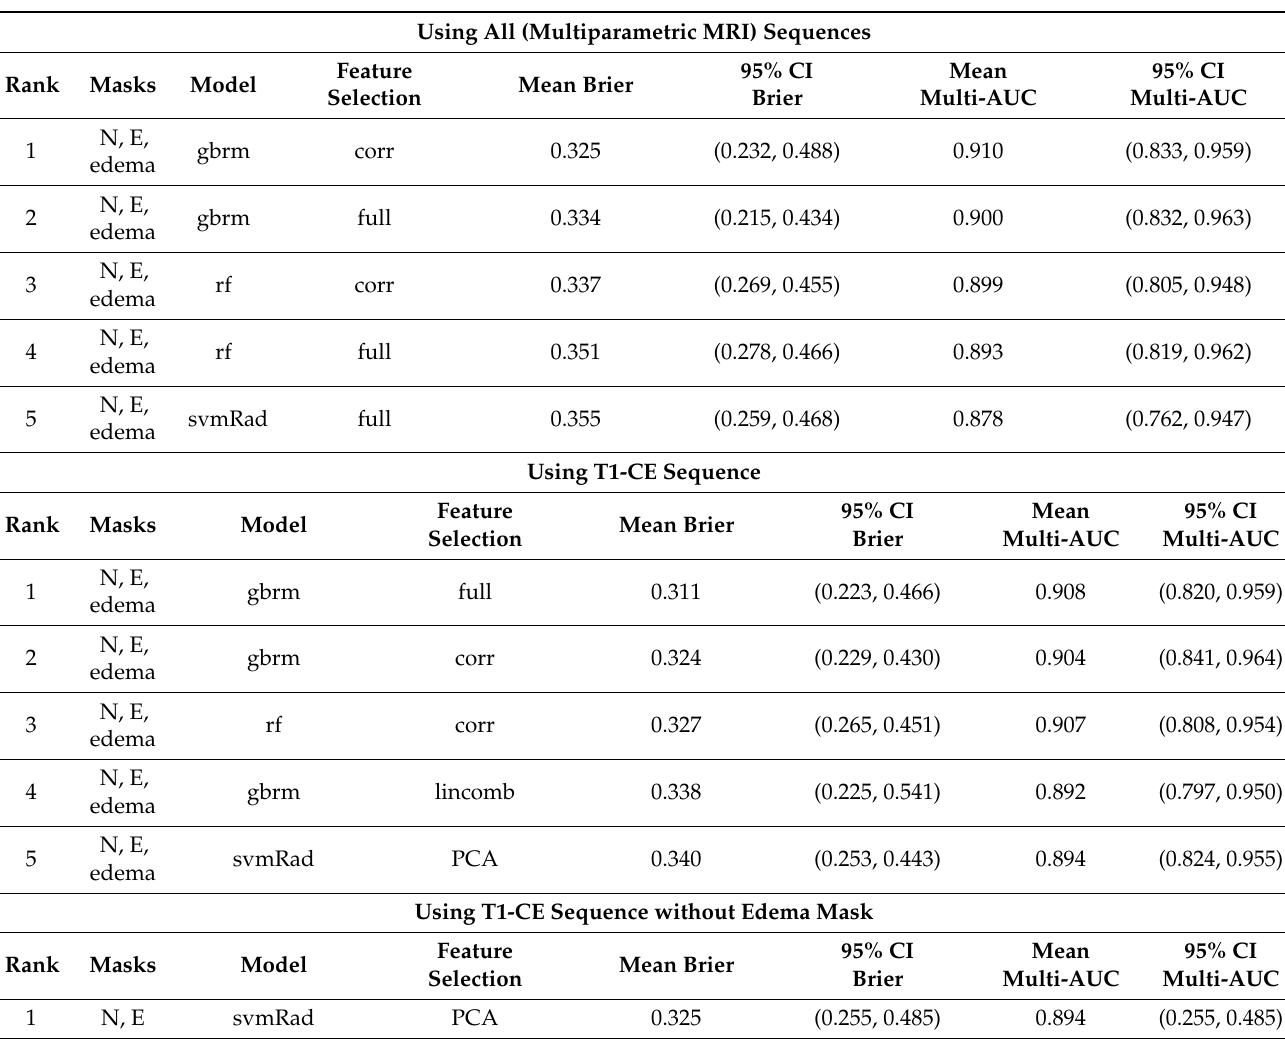
Table 3. Top five models with the lowest Brier score for models using all sequence and mask combinations. Using All (Multiparametric MRI) Sequences